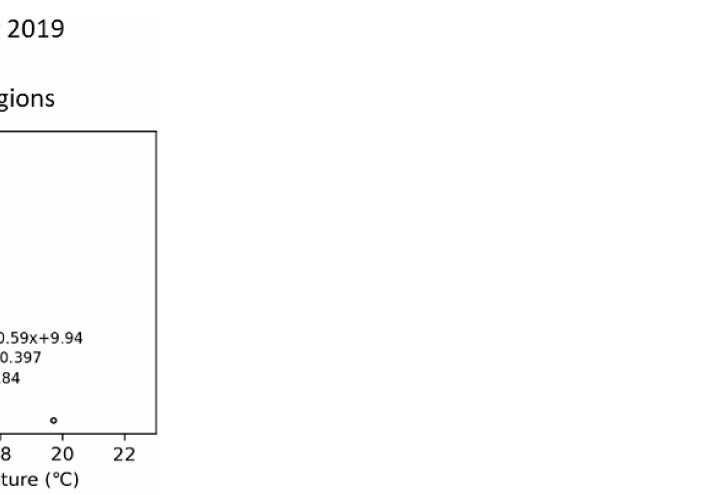
Figure 8. The highest correlation observed between the temperature and the APD, considering the data from Spring 2019.